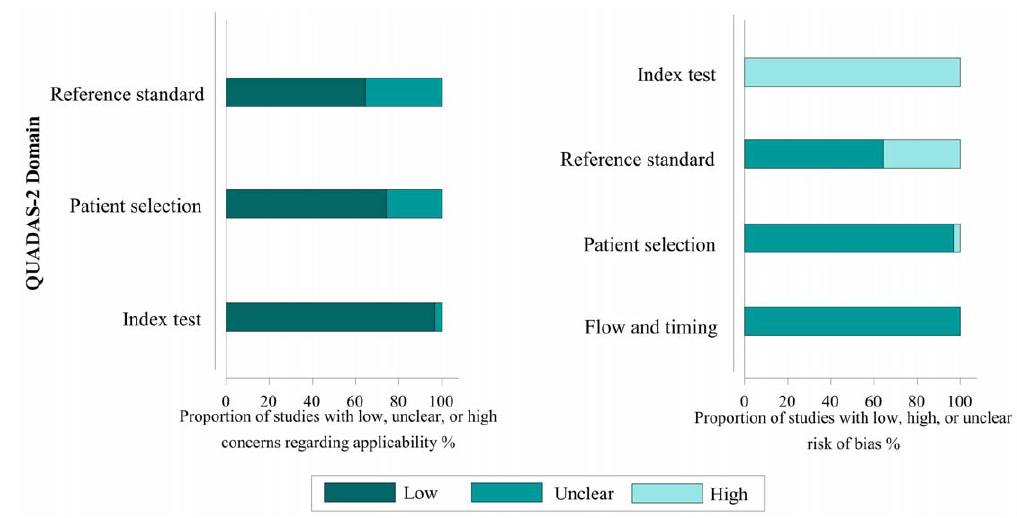
Figure 2. Overall quality assessment of included studies (QUADAS-2 tool).